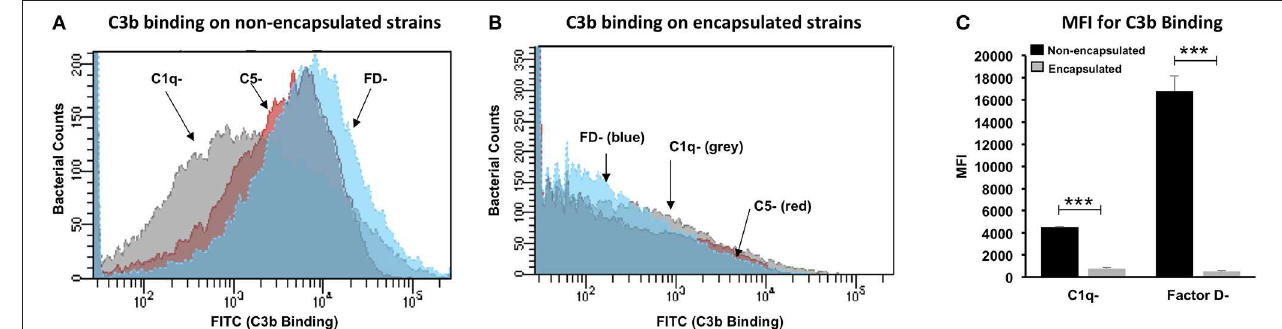
FIGURE 4 | Contributory role of classical and alternative pathways in C3b deposition on Bacillus anthracis. Flow cytometry histogram for C3b deposition on non-encapsulated (A) and encapsulated (B) B. anthracis strains incubated in 10% human serum deficient in complement component C1q (C1q–), factor D (FD–), and C5 (C5–). Gray, red, and blue histogram shading represents C3b deposition in C1q–, C5–, and FD– deficient sera, respectively. (C) C3b binding represented as mean fluorescence index (MFI) observed with non-encapsulated (black bars) and encapsulated (gray bars) B. anthracis strains incubated in C1q and FD sera. Each bar represents the mean of three independent experiments. Error bars represent standard error of the mean. Statistical significance is highlighted by the following denotations: *** for P -value < 0.001.